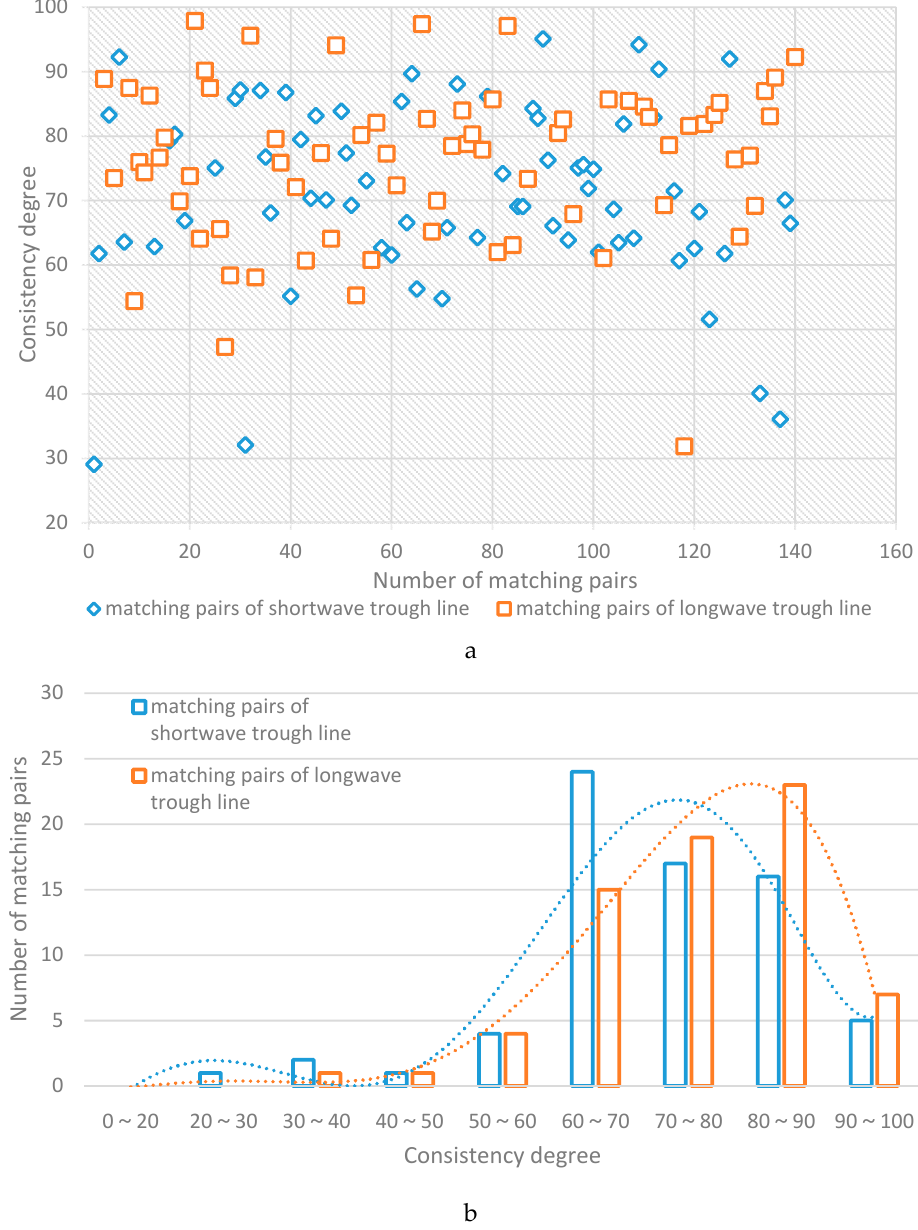
Figure 8. Results of comparison experiments ( a ) and the statistical results ( b ), where the blue and orange dotted lines represent the polynomial fitting of two types of matching pairs, respectively.